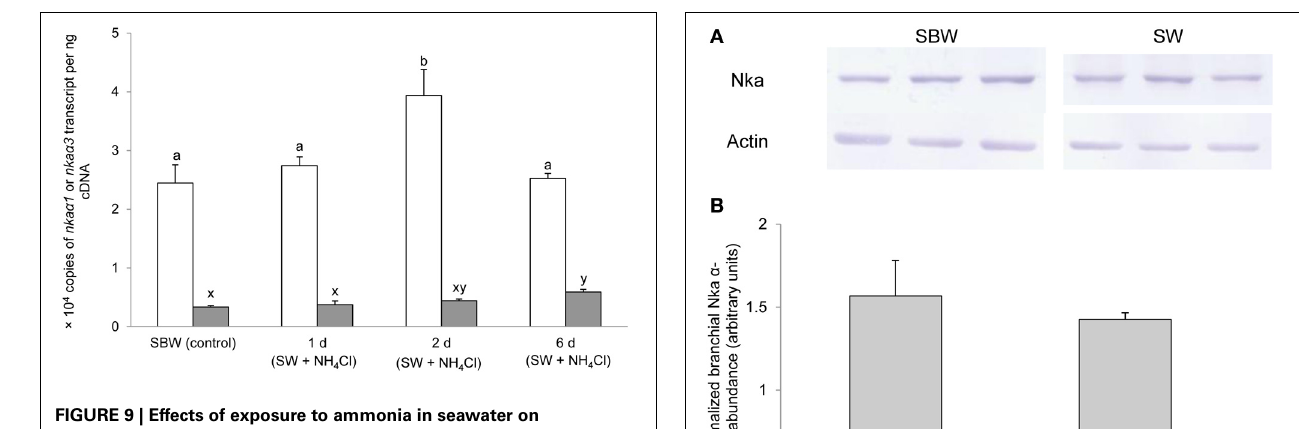
FIGURE 9 | Effects of exposure to ammonia in seawater on Na + /K + -ATPase ( nka ) α 1 and nka α 3 mRNA expression. Absolute quantification (copies of transcript per ng cDNA) of nka α 1 ( (cid:2) ) and nka α 3 ( (cid:3) ) in gills of Periophthalmodon schlosseri kept in slightly brackish water (SBW; salinity 3) for 2 weeks (control) or after 1, 2, or 6 days of transfer from SBW to seawater (SW; salinity 30) containing 50mmol l − 1 NH 4 Cl. Results represent mean + s.e.m. ( N = 4). Means not sharing the same letter are significantly different ( P < 0 . 05).